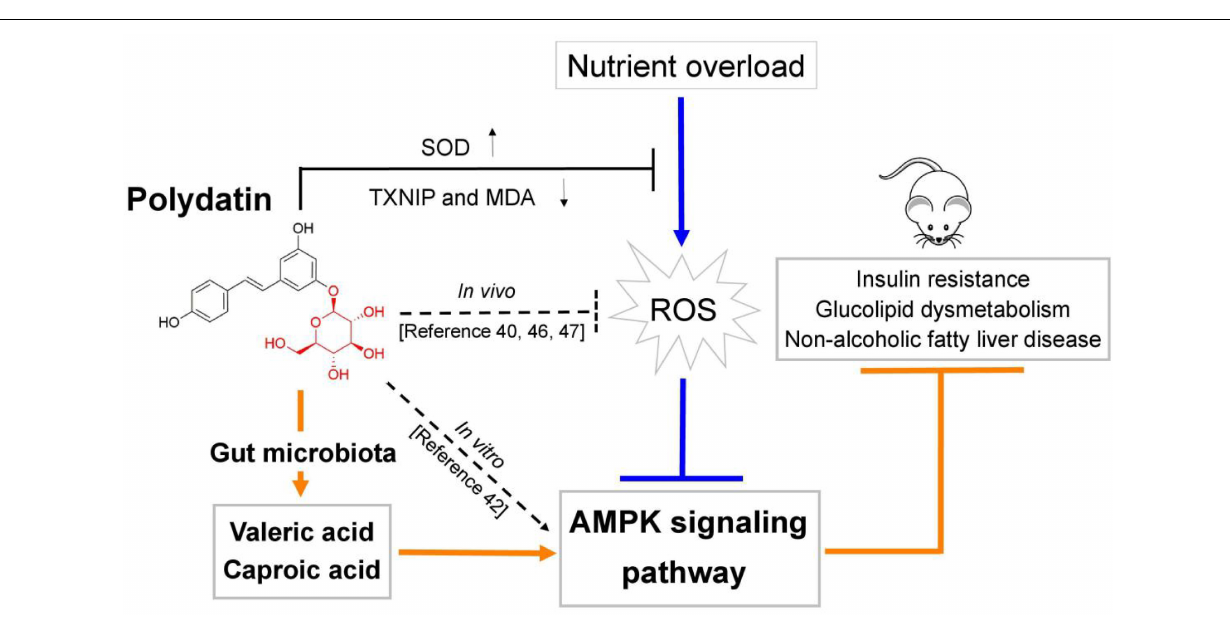
FIGURE 8 | Schematic diagram showing the underlying mechanisms of polydatin administration on ameliorating energy homeostasis